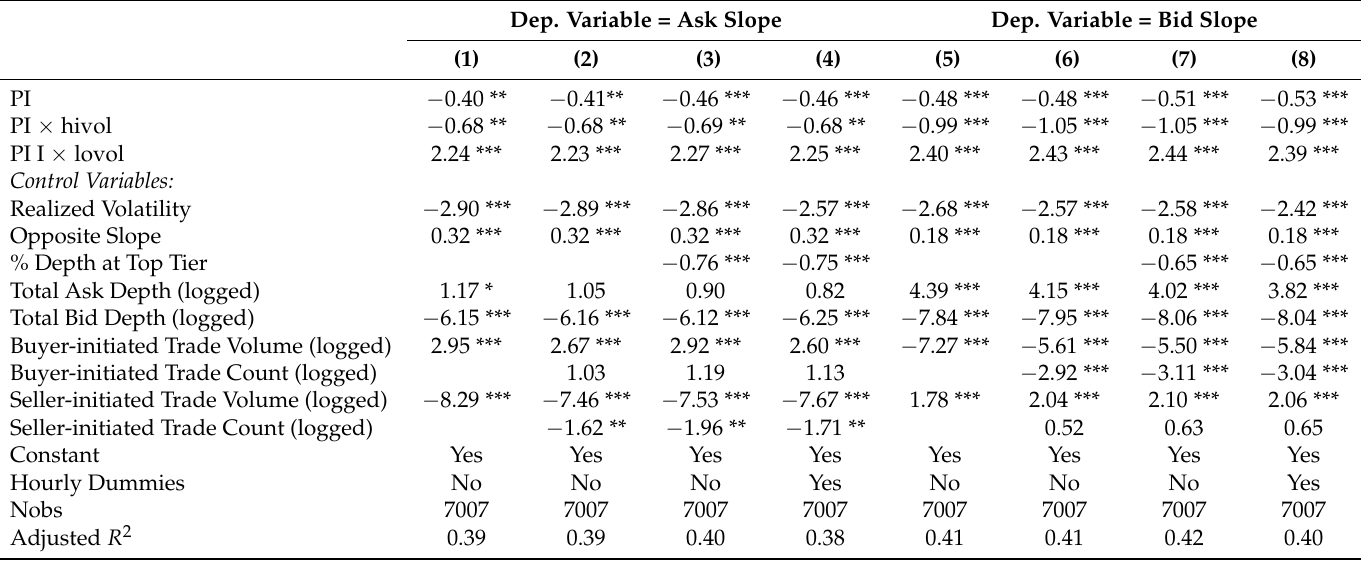
Table 4. Regression of limit order book slope on adverse selection and information environment indicators. The slope of the order book on each side is estimated from order book snapshot prevailing at the end of each hour. Adverse selection (‘PI’) is measured by the price impact of order book events over each hour, as described in the text. Days with large value shock (‘hivol’) have both realized volatility and high-low range measures in the top quartile of their respective distributions. Days with low value shock (‘lovol’) are similarly defined using the bottom quartile. Controls include the percent of same-side depth at the top tier, slope on the opposite side, the total quantity of all ask limit orders, the total quantity of all bid limit orders, total trading volume and log trade count over each hour split into buyer-initiated and seller-initiated, and hourly realized volatility computed from five-minute returns. All depth and trading volume variables are in the number of coins and log-transformed. Hourly dummies capture the time-of-day effects. Data are from BTC-e for the period from 7 December 2013 to 24 September 2014. ∗∗∗ p < 0.01, ∗∗ p < 0.05, ∗ p <